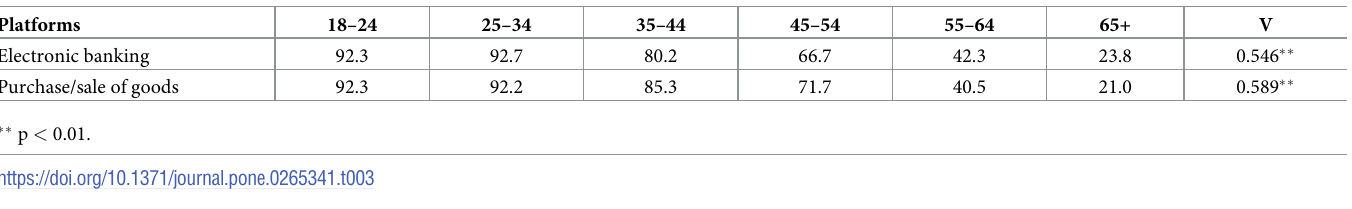
Table 3. Poles’ participation in the digital economy by age